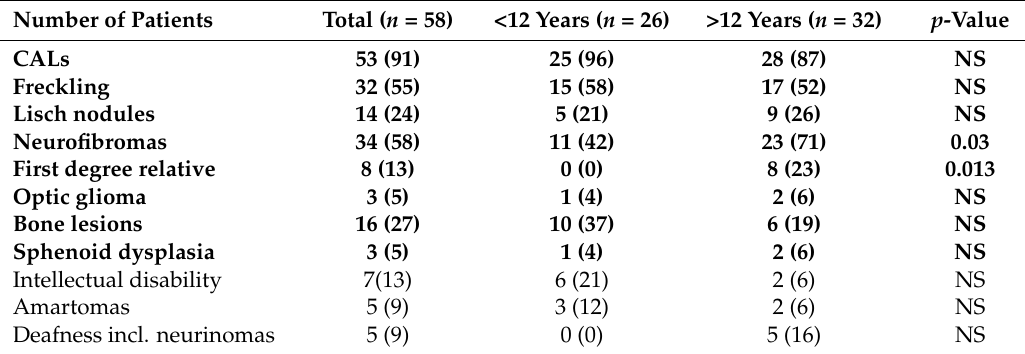
Figure 1. Outline of the patients investigated in this study. Table 1. Clinical data in mutated